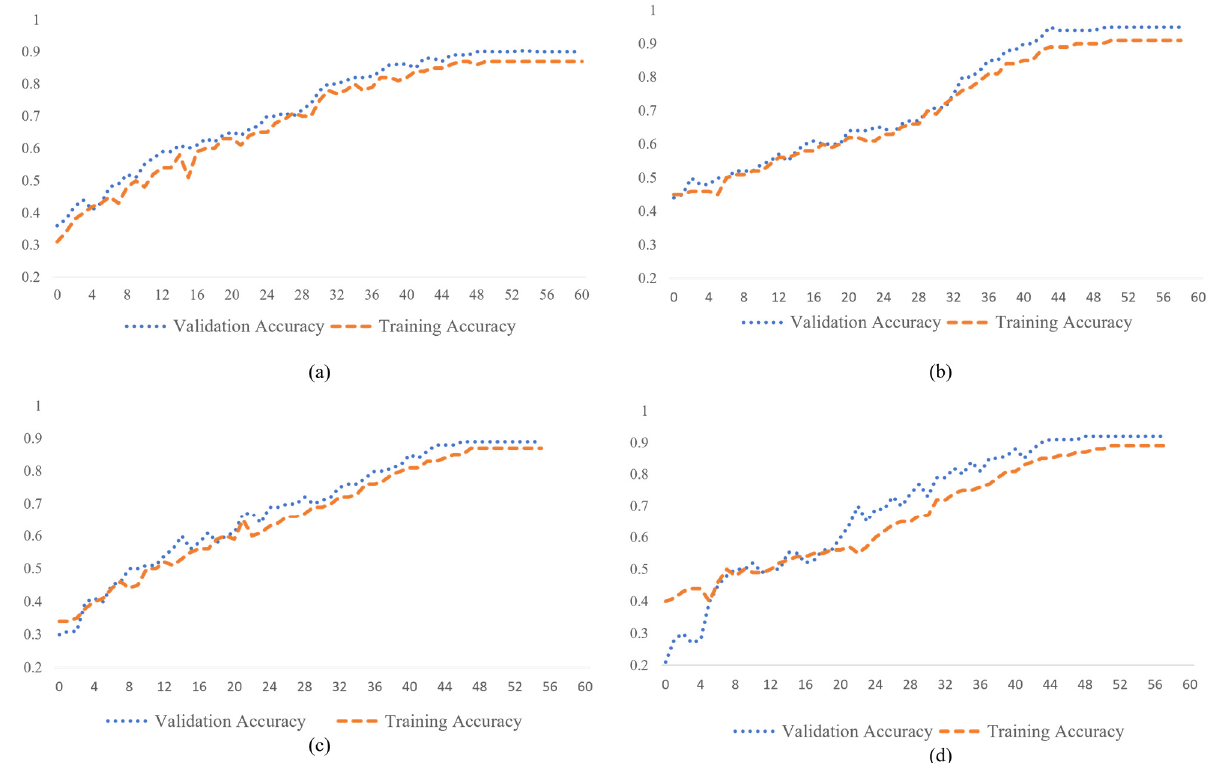
Figure 7. Training and validation curve of accuracy for the deep learning models on CT scan and CXR datasets: ( a ) SCovNet model for CT scan images; ( b ) ResNet18 model for CT scan images; ( c ) SCovNet model for CXR images; ( d ) ResNet18 model for CXR images.